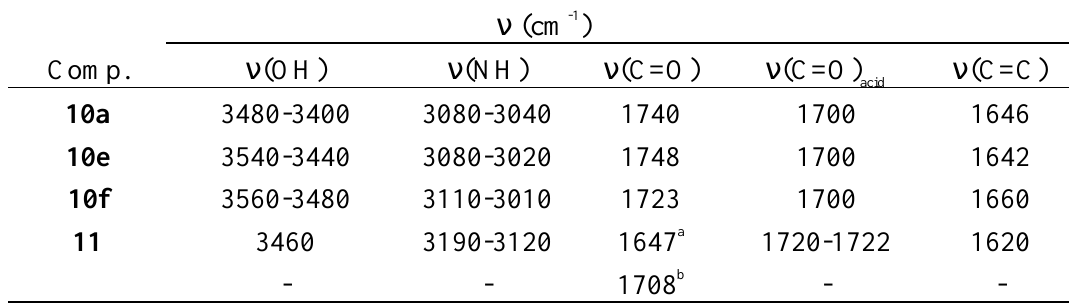
Table 4. IR spectral data of synthesized compounds 10 and 11